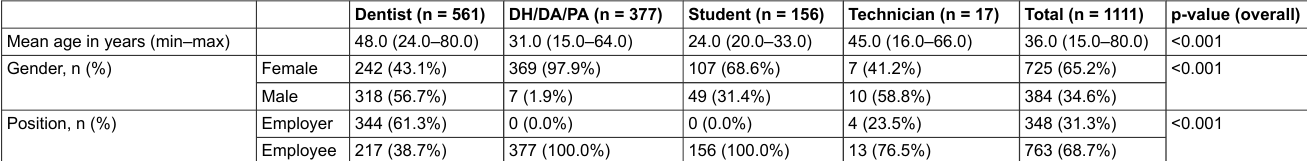
Table 1: Characteristics of participants by profession.